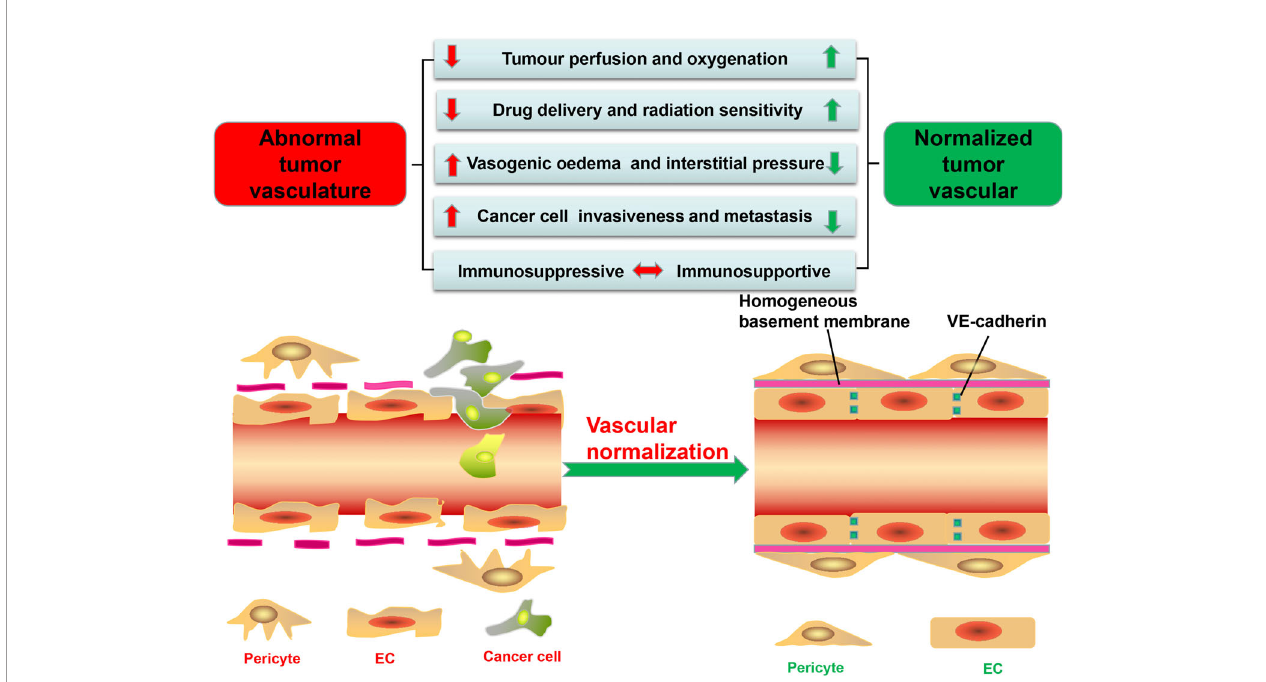
FIGURE 1 | Signi fi cant differences in structure and function between tumor vessels and normal vessels. tECs have an irregular shape and lack VE-cadherin, leading to high permeability and disordered arrangement. Besides, tumor vessels have low pericyte coverage and are often separated from endothelial cells (ECs). The basement membrane of tumor vessels is also incomplete and discontinuous, further increasing vascular permeability. These structural abnormalities stimulate the formation of a hypoxic, acidic tumor microenvironment (TME); promote the proliferation and metastasis of tumor cells; and reduce the ef fi cacy of tumor therapy. Furthermore, the abnormal TME promotes the immunosuppression. The methods of tumor vascular normalization introduced in this paper can restore the normal structure and function of blood vessels and enhance the ef fi cacy of antitumor